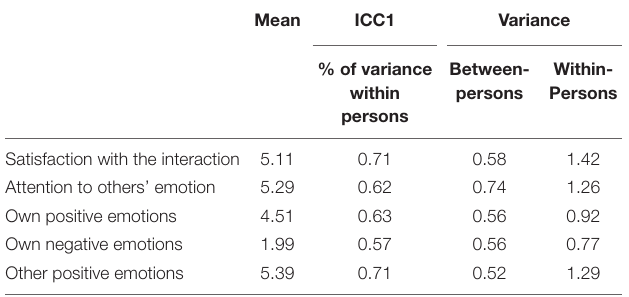
TABLE 2 | Multilevel summary statistics.